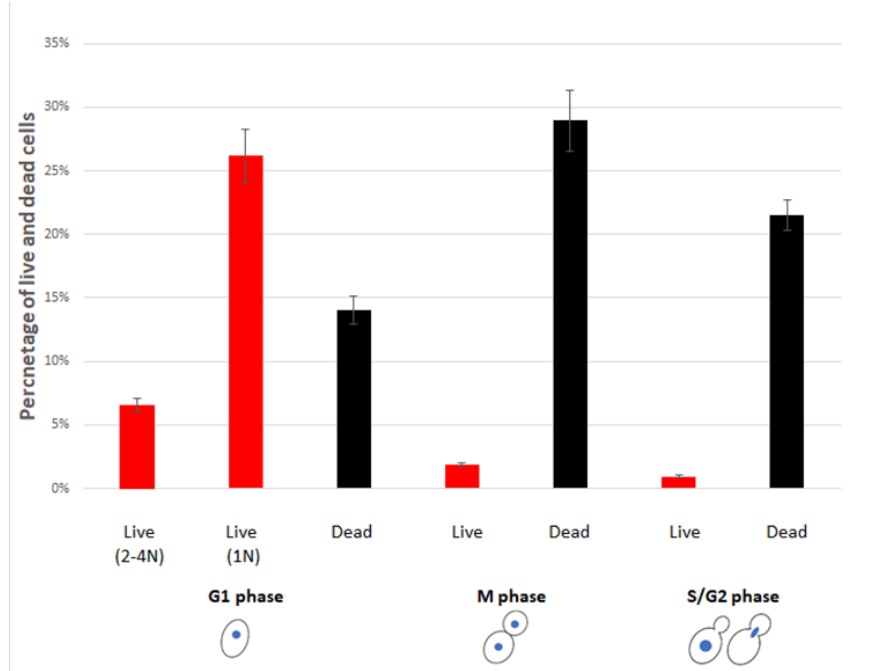
FIGURE 4: Percentage of live and dead stationary cells in different cell cycle phases after 14 days of desiccation. Two different popula- tion of live G1 cells were observed, one with high DNA fluorescence intensity (equivalent to 2-4N), and the other with 1N DNA fluores- cence intensity. Live and dead cells were identified by PI staining. Cell cycle status was determined by images of bright field and fluores- cence brightener-28 stained cells. Approximately 400 cells were counted from each experiment and the data were presented as mean ± standard error from three inde- pendent